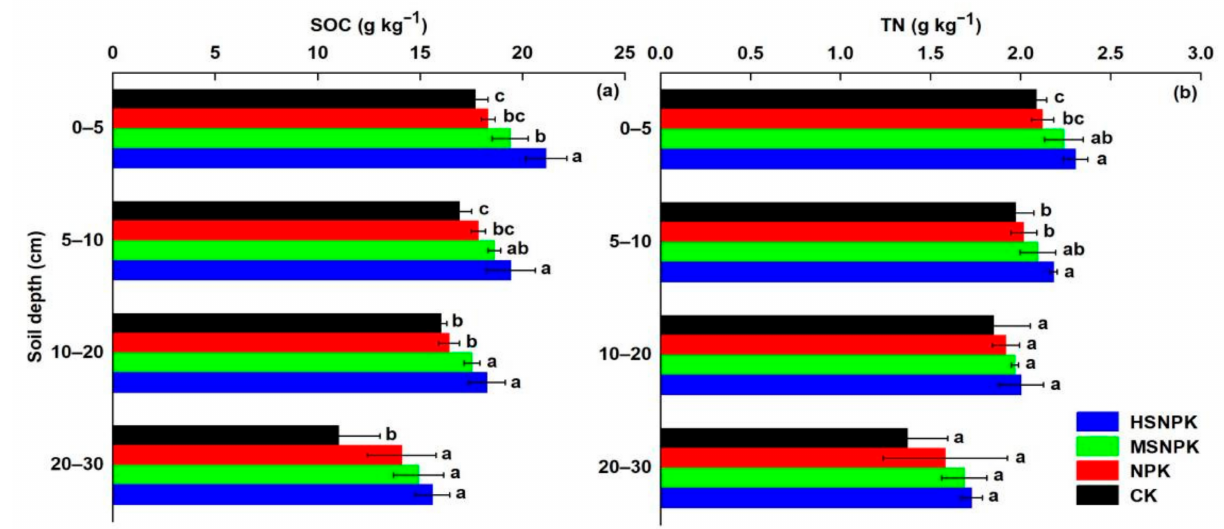
Figure 3. Changes in ( a ) SOC and ( b ) soil TN content at different soil layers under different treatments. The values are means ± SD ( n = 3). Different letters mean statistically significant differences at the 0.05 level. CK: unfertilized control; NPK: mineral NPK fertilizer; MSNPK: moderate wheat straw incorporation (3 t ha − 1 ) plus NPK; HSNPK: high wheat straw incorporation (6 t ha − 1 ) plus NPK. SOC: soil organic C; TN: total